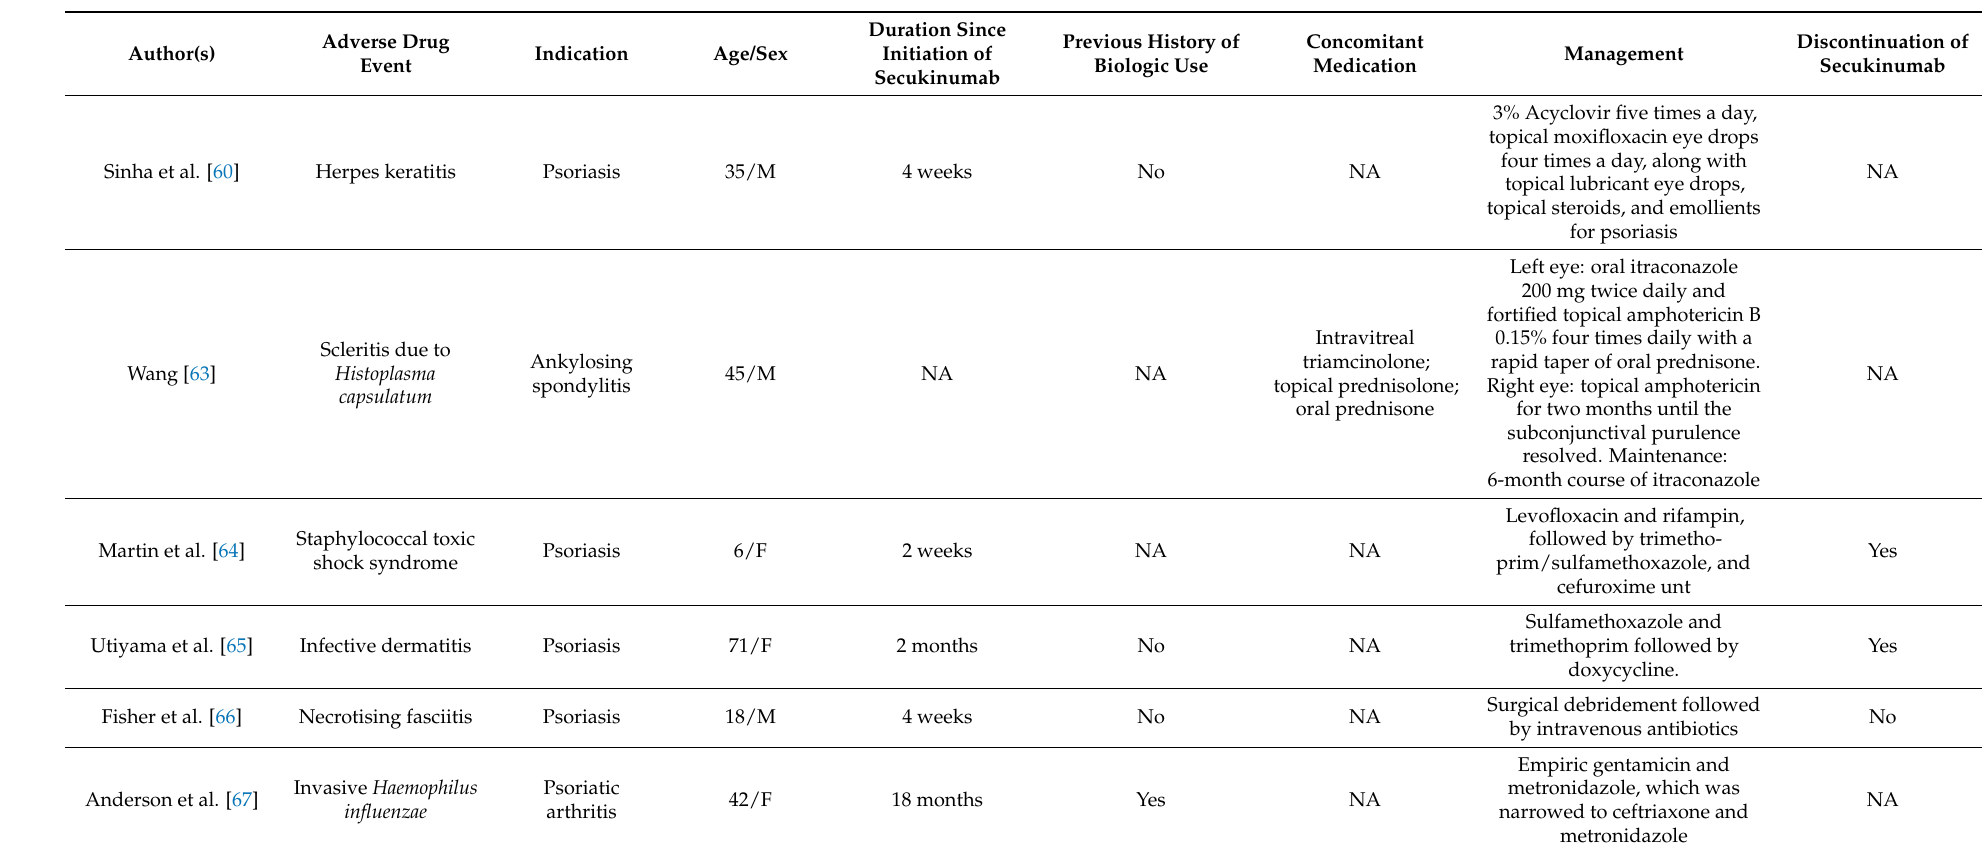
Table 2. Case reports of infections reported with secukinumab